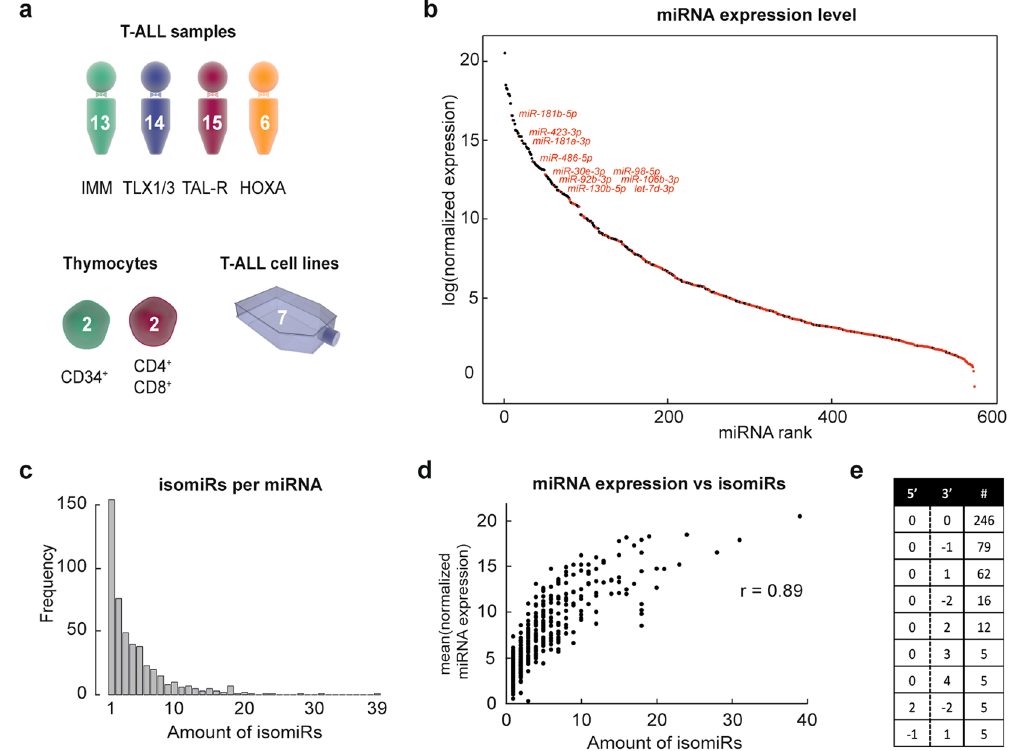
Figure 1. Small RNA-sequencing of T-ALL samples, healthy thymocytes and cell lines detects novel T-ALL miRNAs and isomiRs. ( a ) Overview of samples profiled by small RNA-sequencing. ( b ) Dot plot representing the mean normalized expression levels of all 574 miRNAs detected by small RNA-sequencing of the 48 T-ALL patient samples. Each dot represents one miRNA and the miRNAs are ranked from highest to lowest mean expression. Black dots are miRNAs that were already detected by a qRT-PCR platform from previous studies. Red dots are the novel miRNAs detected in T-ALL samples. ( c ) Bar plot visualizing the distribution of the miRNAs by means of the amount of isomiRs they are represented by. ( d ) Correlation plot between the mean expression level of the miRNAs and their amount of isomiR forms. ( e ) Table representing the isomiR form that was represented by the highest expression level for each of the detected miRNAs. The first column denotes the 5 ′ overhangs or deletions, the second column the 3 ′ overhang or deletions of the isomiR in comparison to the canonical miRNA. The third column shows the amount of miRNAs of which the highest expressed miRNA had that isomiR form. (Graphics from